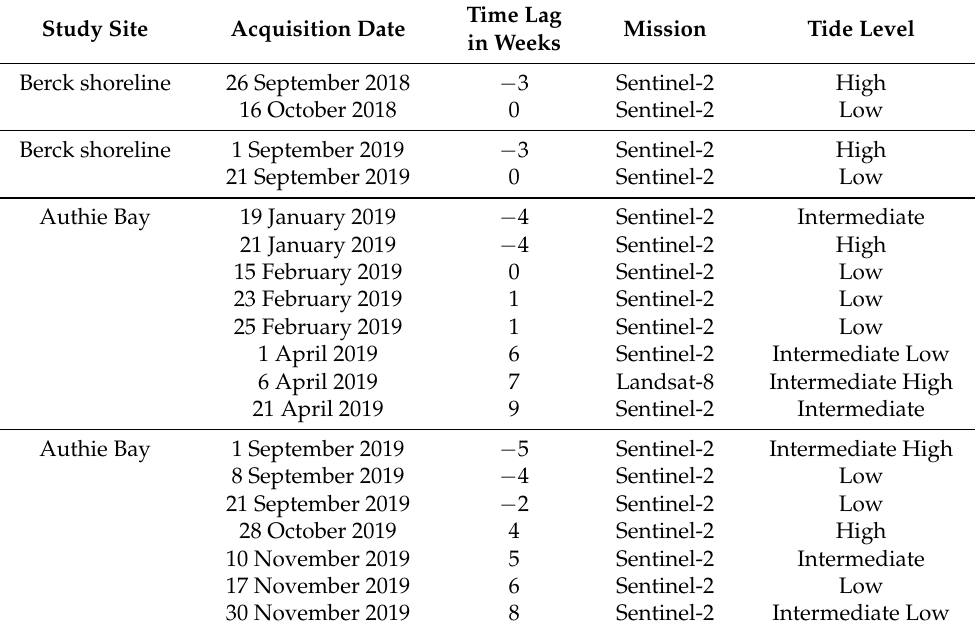
Table 2. Remote sensing images at different tidal stages, used in SDT methods. The time lag refers to the time difference between the acquisition dates of satellite images and ground in situ